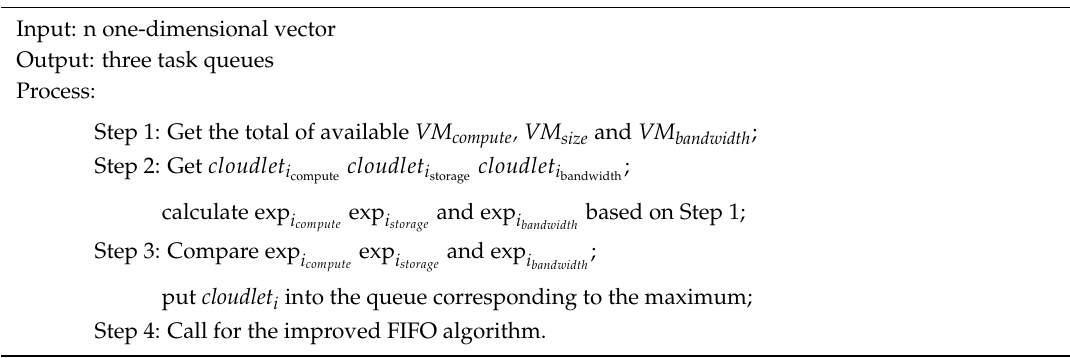
Algorithm 3. The procedure of data preprocessing of